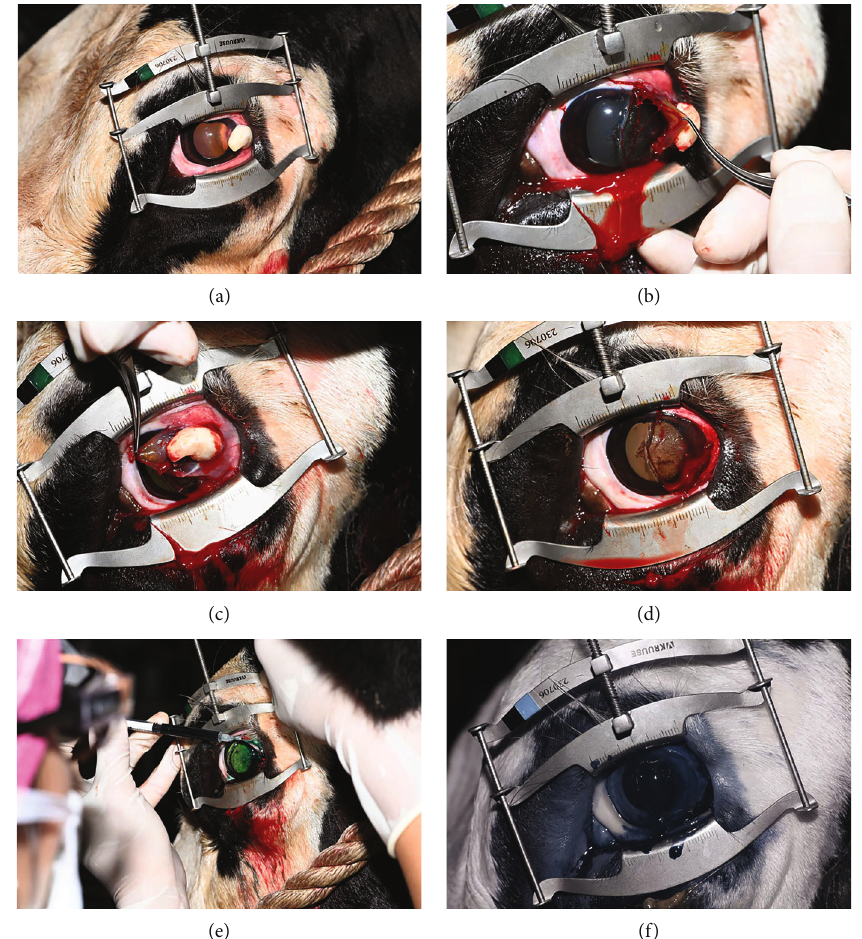
Figure 2: A partial incision super fi cial lamellar keratectomy (PI-SLK) and conjunctivectomy; removal of the corneoconjunctival section (a – d), “ painting ” of infracyanine green onto the keratectomy site and injection into the perilimbal conjunctiva (e), and infrared imaging showing no gross evidence of in fi ltrate